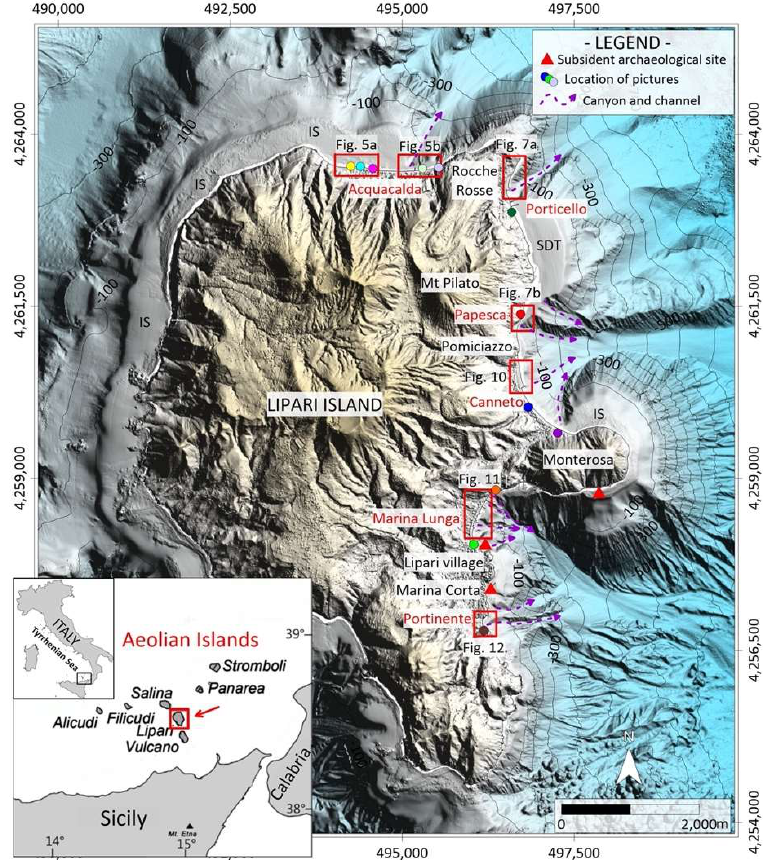
Figure 1. High-resolution digital elevation model of Lipari Island and offshore sectors (contour depths in meters), with location of the coastal areas under study. Red boxes and color dots represent the areas of the maps and the location of the pictures reported in the following figures, respectively. Red triangles represent the location of subsident historical–archaeological sites (see text for details). The position of the main canyon and channel heads affecting the eastern coastal area of Lipari in shallow water is also indicated, together with that of other submarine features cited in the text (IS: insular shelf, SDT: submarine depositional terrace). In the inset: location of the Aeolian Islands in the southern Tyrrhenian Sea.